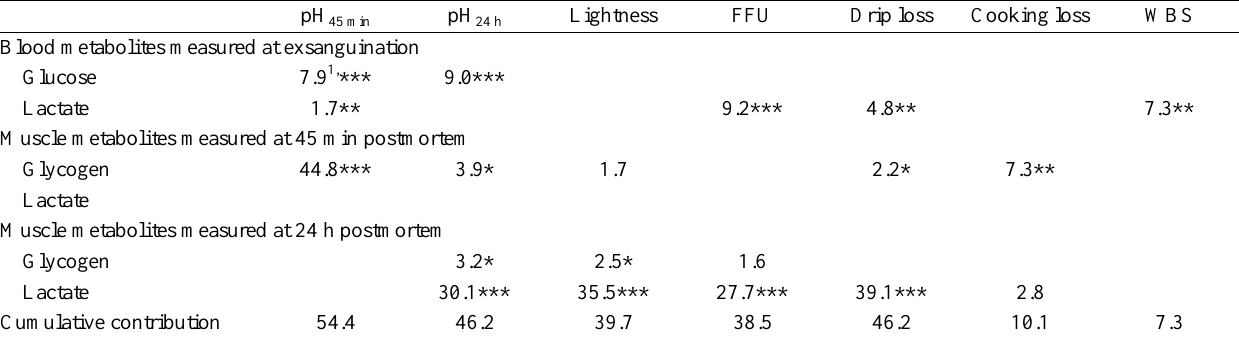
Table 5. Proportion of variability in certain pork quality traits explained by blood and muscle metabolites using stepwise regression